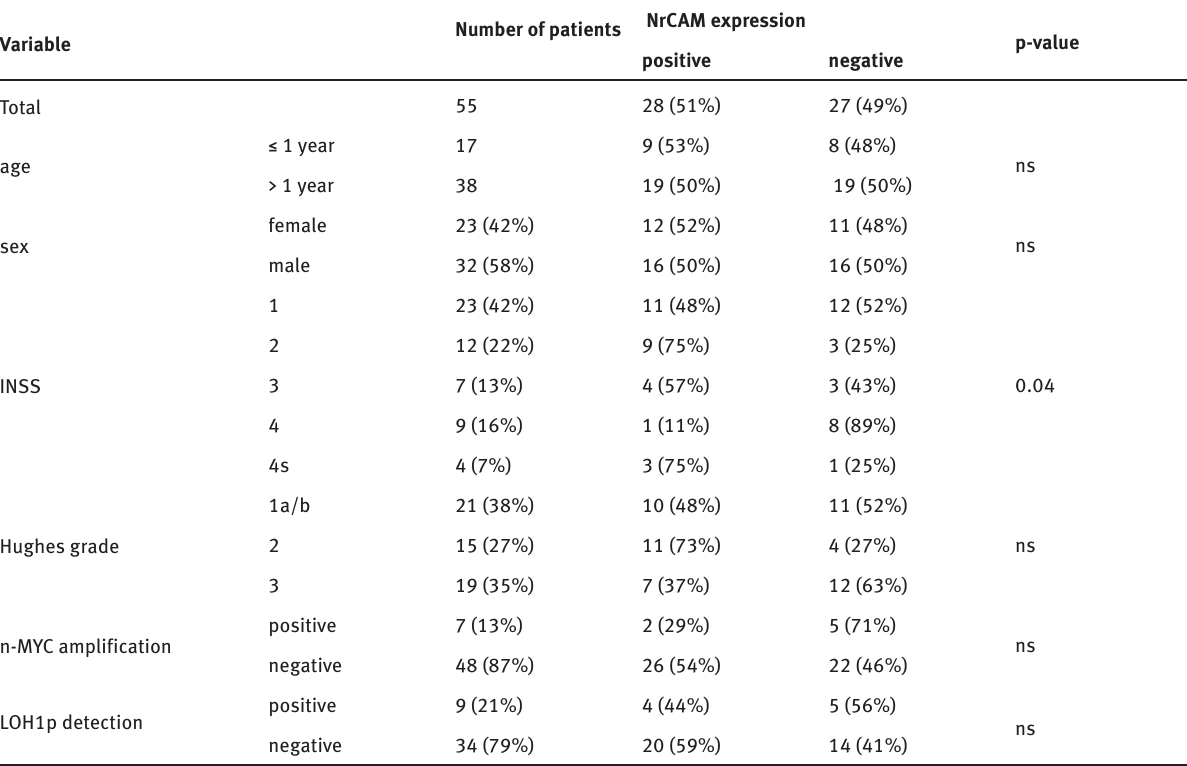
Table 2: NrCAM expression as well as clinical, pathologic and molecular characteristics of the analysed neuroblastoma tissue samples. Statistical analyses by using cross-tables, two-sided Fisher´s and Chi-squared